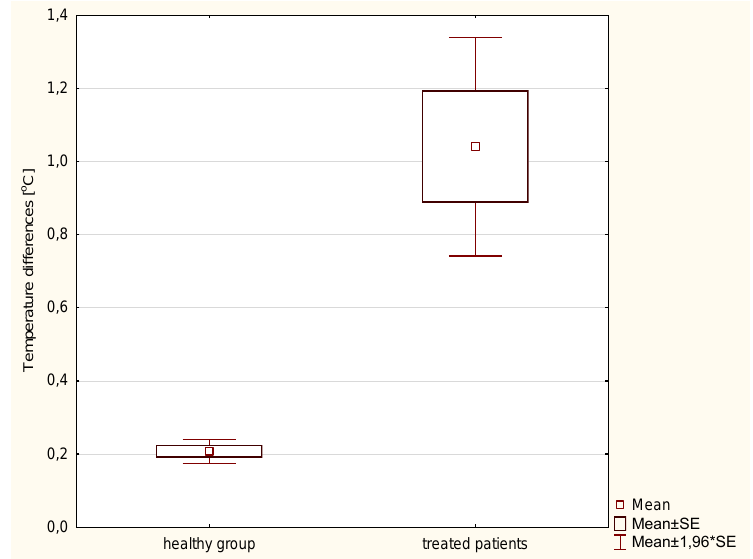
Figure 6. Differences in mean temperatures between breasts (right and left) in healthy patients and differences in mean temperatures between PTV and healthy breasts in patients in the third week of